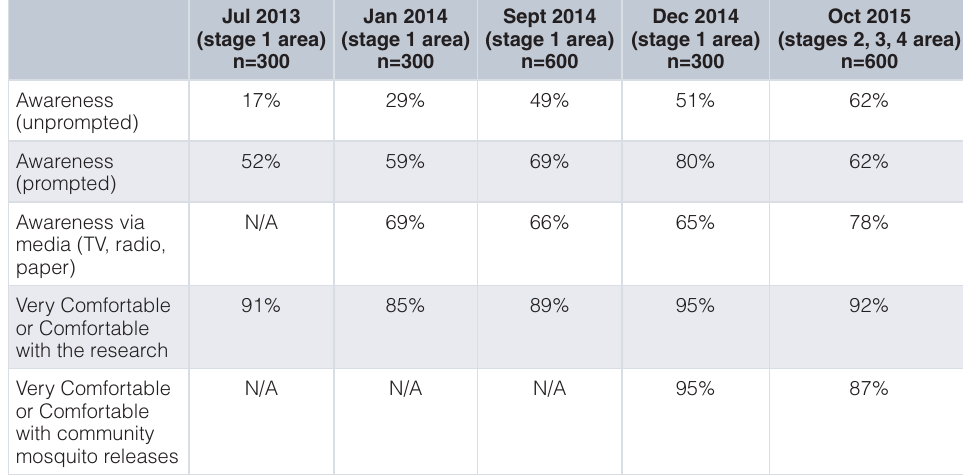
Table 2. Results of telephone surveys seeking to understand community awareness and support for the